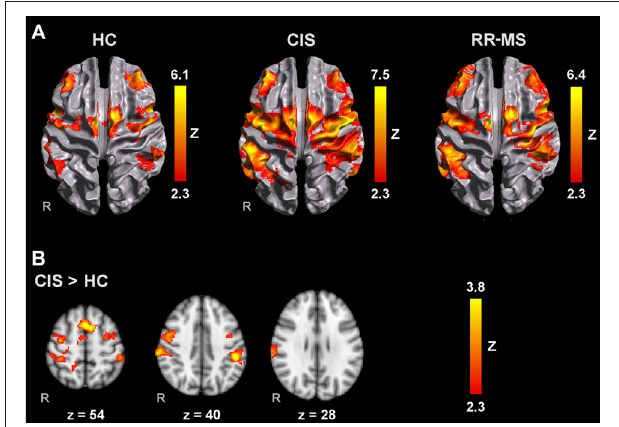
FIGURE 2 | Brain activation during MM with the left hand (A) in HC, CIS and RRMS groups and (B) comparisons between groups. Results are cluster corrected for multiple comparisons ( Z > 2.3; P < 0.05) and are shown overlaid on the MNI template. CIS patients and HC, and in CIS patients compared to HC, in agreement with the literature (Pantano et al., 2005; Rocca et al., 2005; Lenzi et al., 2007). During MM, there was a recruitment of the same motor network although with less extensive M1 and S1 activation and additional activation of prefrontal and parietal regions ( Figures 1A , 2A